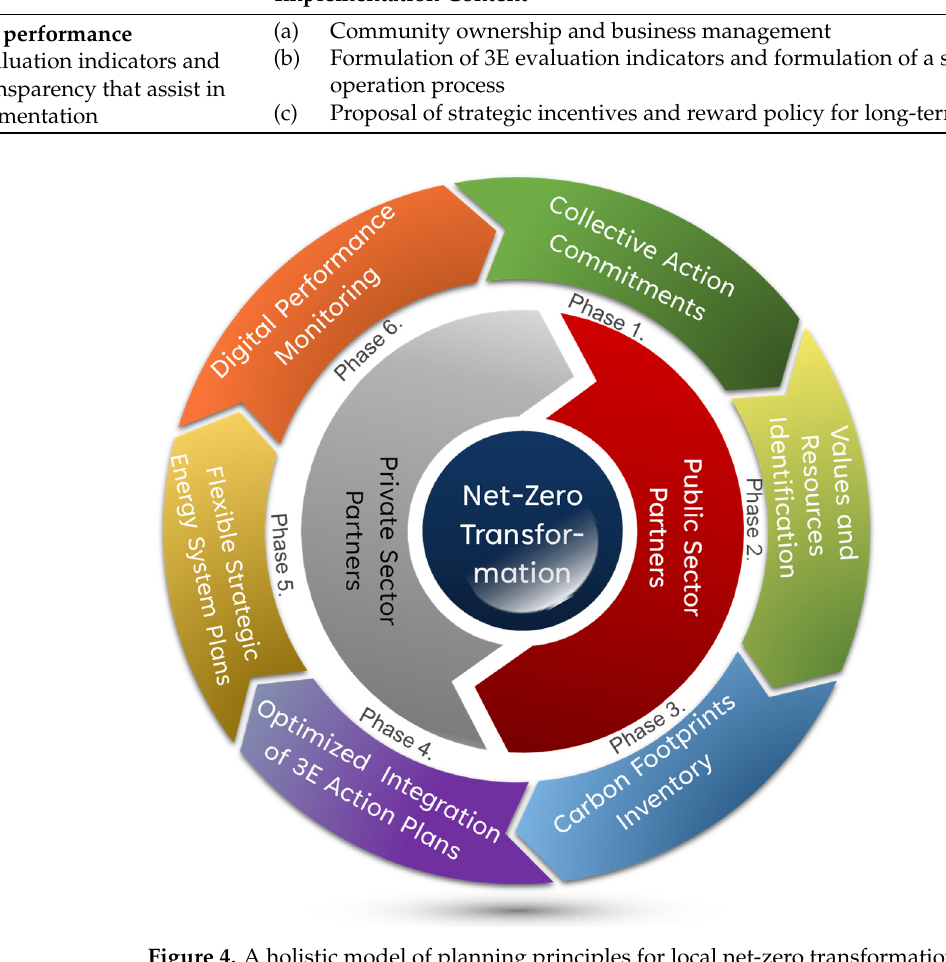
Figure 4. A holistic model of planning principles for local net-zero transformation.